Question: Looking at the figure, what chart type is it?
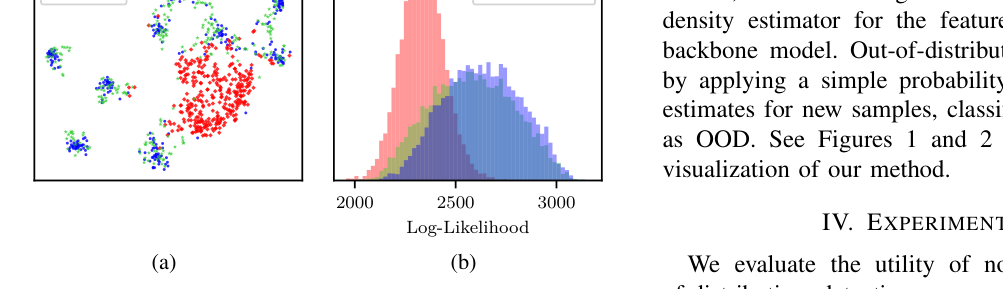
Answer: scatter